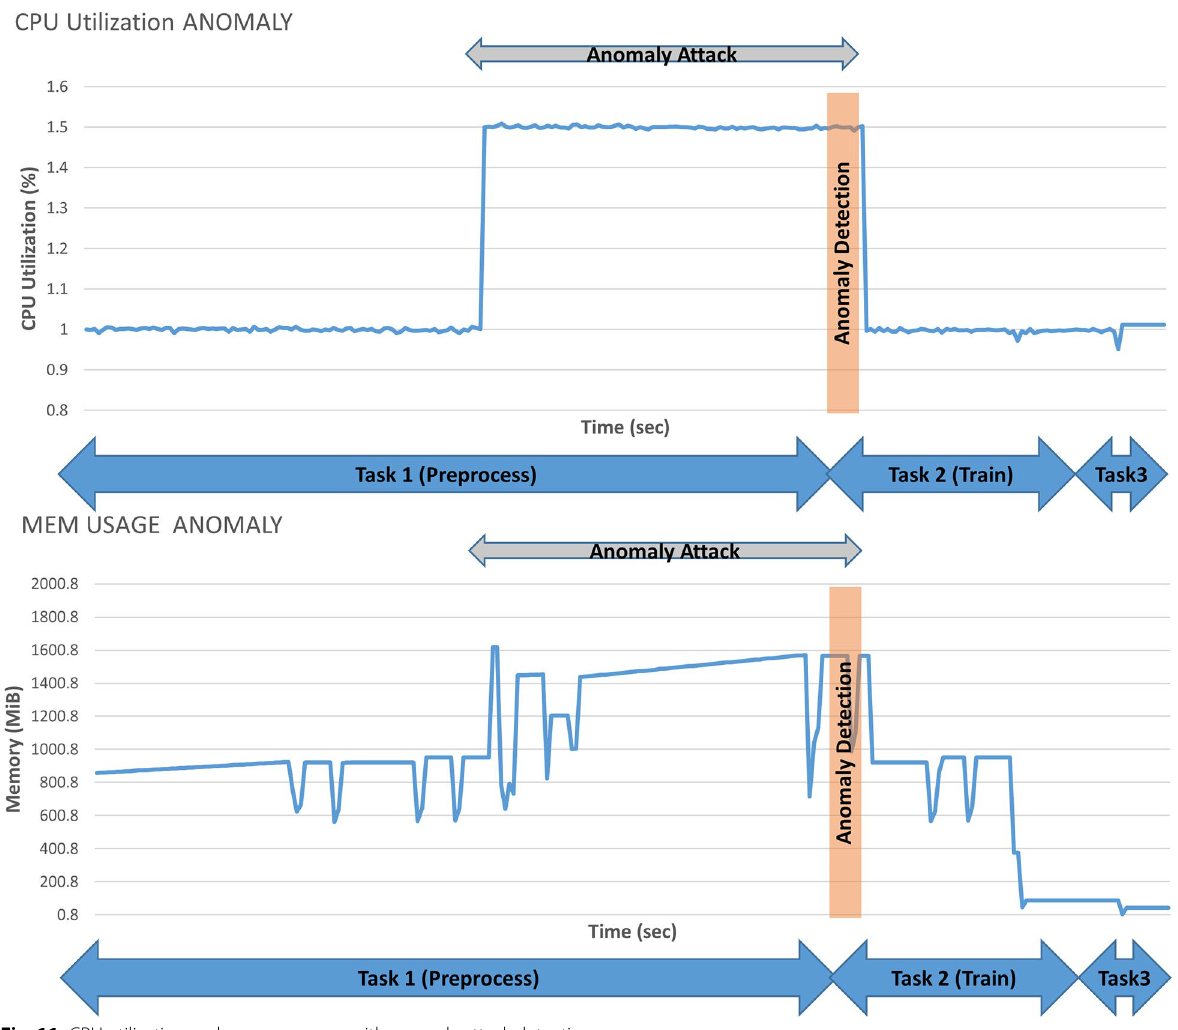
Fig. 11 CPU utilization and memory usage with anomaly attack